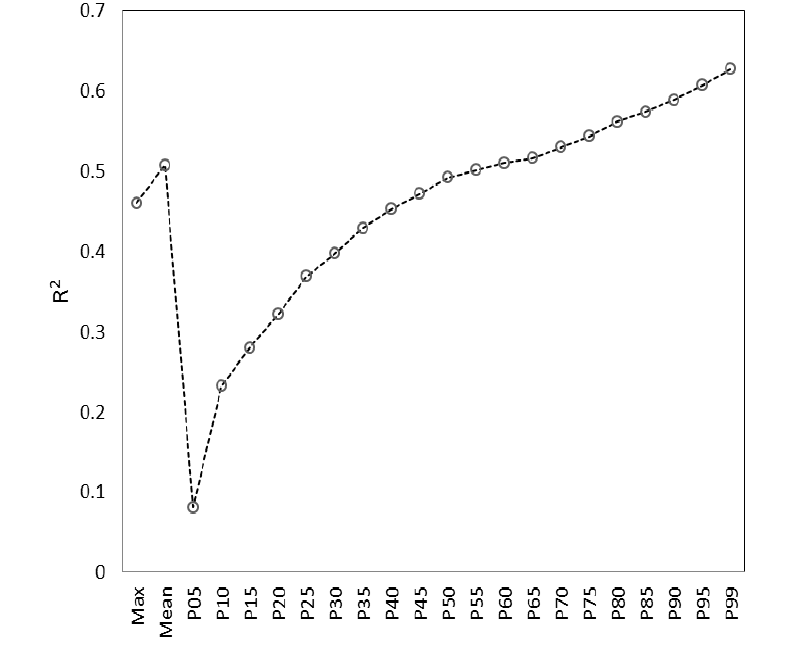
Figure 10. Coefficient of determination (R 2 ) derived from the relationship between LAIe and maximum, mean and percentile values (5th, 10th, 20th, 25th, ..., 95th percentiles) derived from the DAI-derived Normalized Difference Vegetation Index